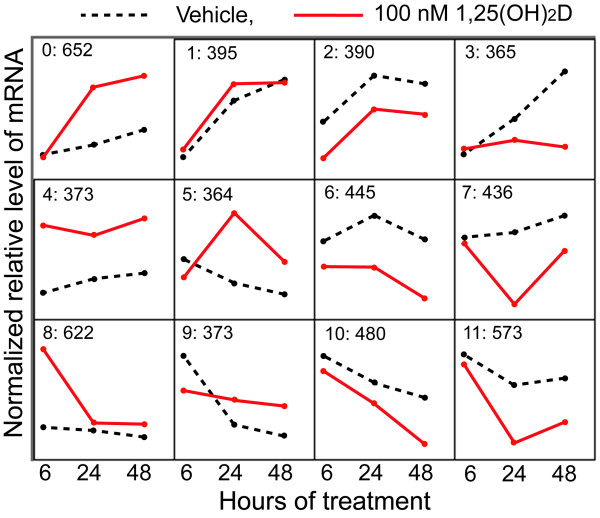
Self-organizing map analysis of transcripts significantly differentially expressed after 1,25(OH)2D treatment in RWPE1 cells. Transcripts that were found to be significantly differentially expressed (FDR<5%) in at least one time point by 1,25(OH)2D treatment (n = 5435) were clustered into 12 groups using self organizing map. The X-axis for each cluster represents hours after treatment (6, 24 and 48 h). The Y-axis for each cluster represents normalized relative level of mRNA expression (in arbitrary units). The number of genes within each cluster in listed at the top, along with the cluster number.